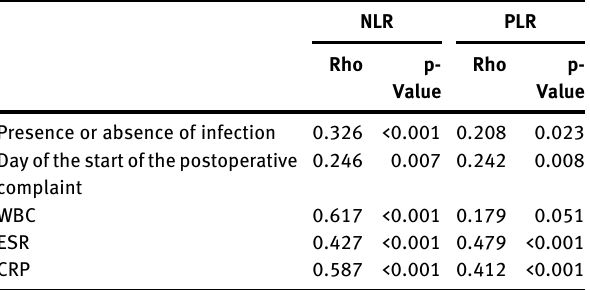
Table  : Correlation analysis of NLR and PLR values and de- mographic data and other laboratory measurements.